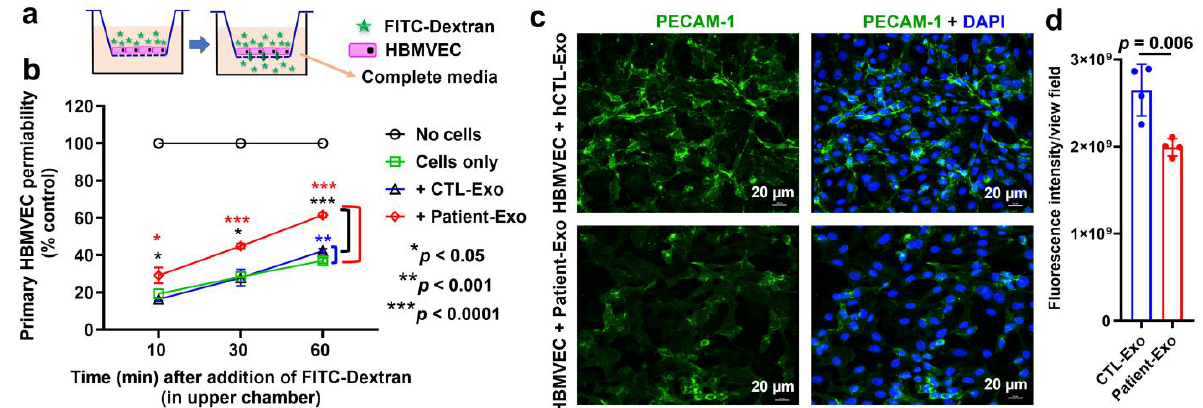
Figure 9. In vitro BBB permeability assays and the detection of PECAM-1 by immunofluorescence